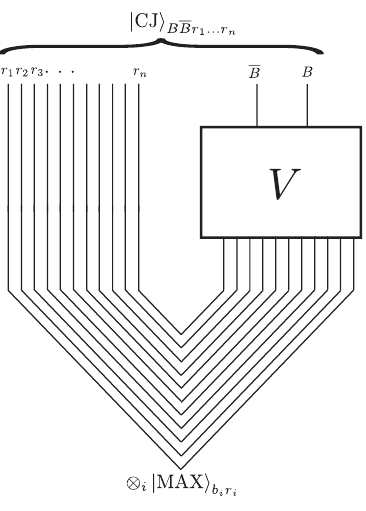
Figure 3: The Choi-Jamiolkowski state | CJ 〉 . Angled lines represent maximally en- tangled states, with one half of the maximally entangled state input into V